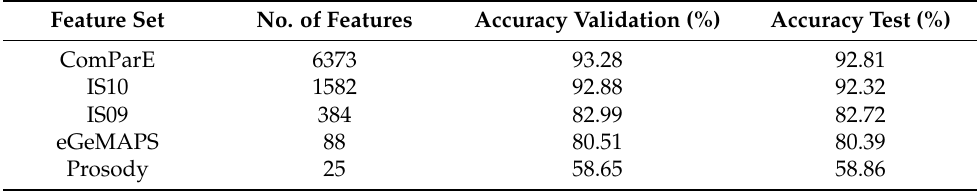
Table 1. Classification results showing three-class trust prediction using speech acoustics. Feature